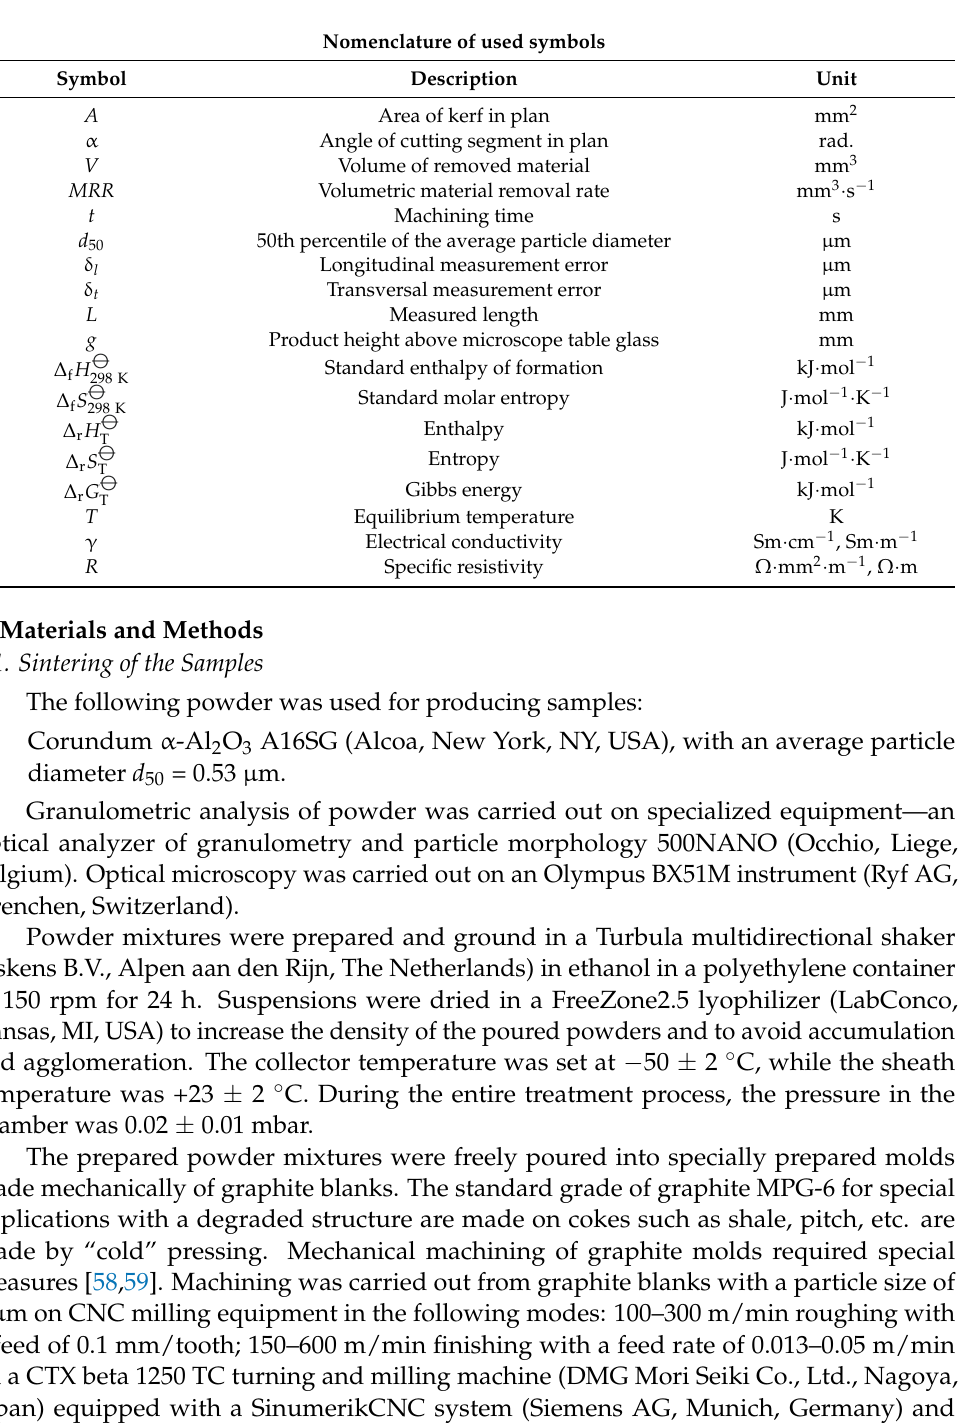
18 of 24 Table 14. Calculated enthalpy of formation of some Ni-containing substances. Chemical Reaction